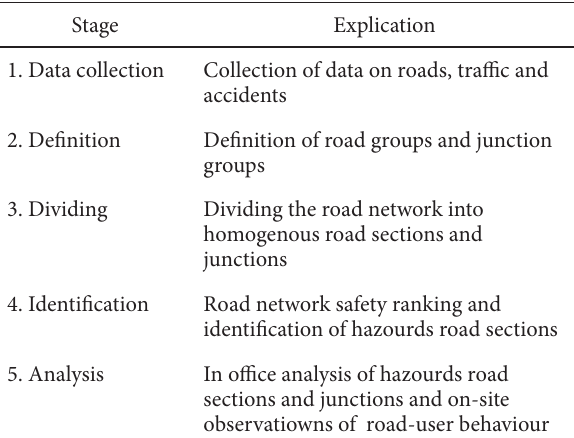
Table 1. Typical stages in road network safety and high accident concentration sections